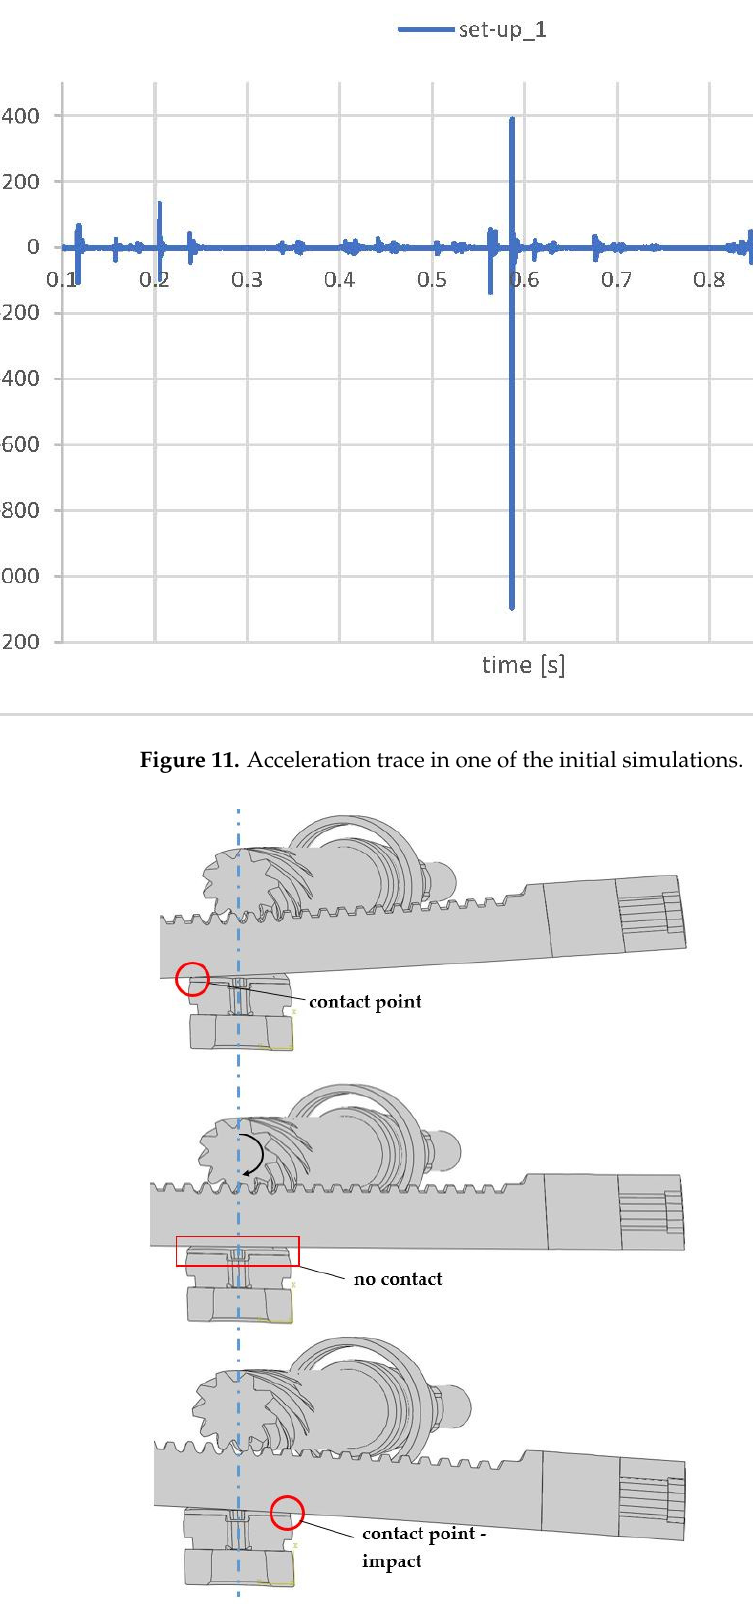
Figure 12. The main impact mechanism.